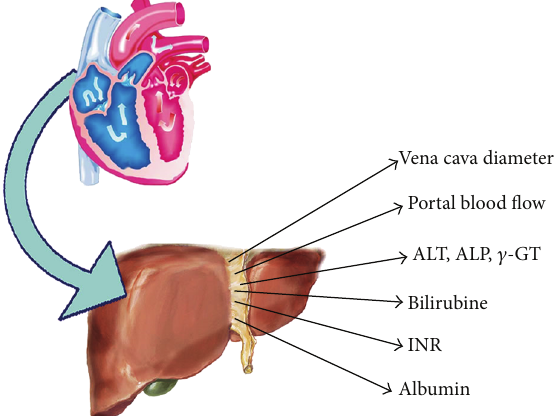
Figure 3: Shows the way of liver’s impairment in HF. ALT: Alanine Transaminase; ALP: Alkaline Phosphatase; INR: International Nor- malized Ratio.